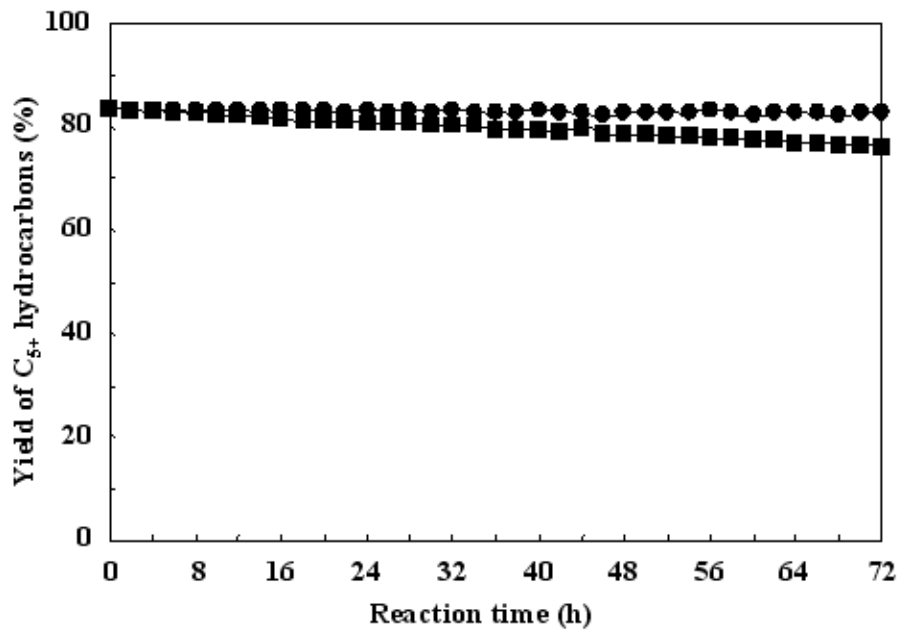
Figure 8. Time courses in the hydrotreatment of waste cooking oil over Ru/Al and sulfided Ni-Mo/Al -Mont ( ■ ) (reaction conditions: same as those in Table 13